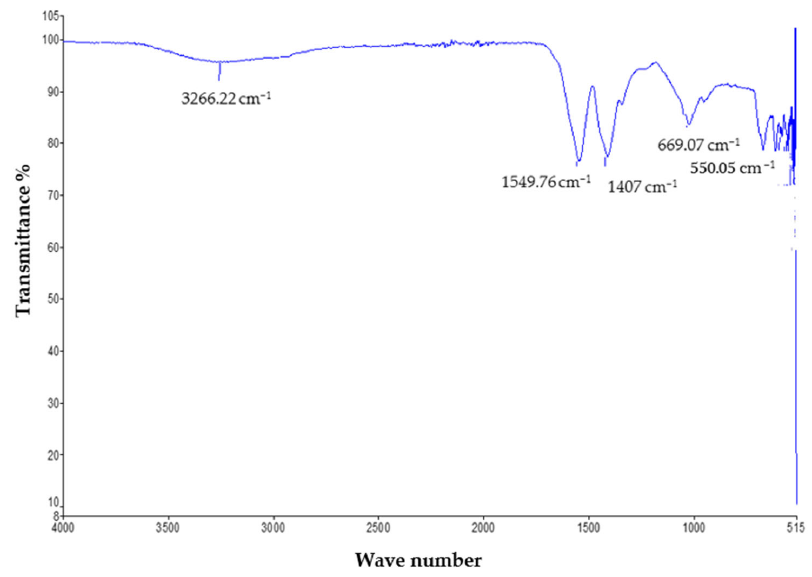
Figure 3. FTIR analysis of the ZnO nanoparticles.